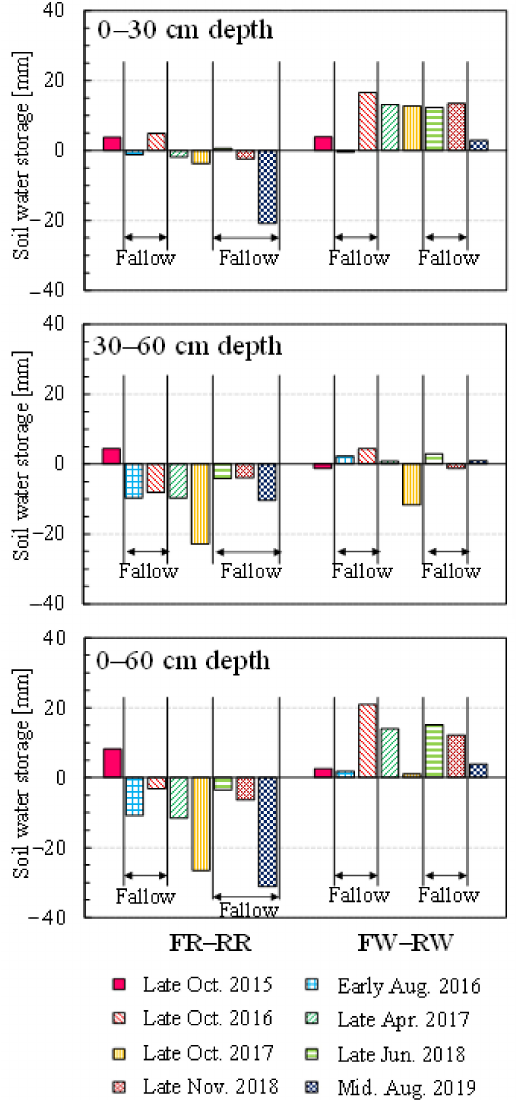
Figure 10. Differences in soil water storage between the fields and rangelands in the root zone (0–30 cm depth), below the root zone (30–60 cm depth), and in the depth of 0–60 cm in the study sites, which were calculated by subtracting the soil water storage in the adjacent rangelands from that in the fields. RW was used instead of RR for FR–RR calculations after October 2017 because RR had considerably higher infiltration than the other sites due to surface inflow from the adjacent road, which continued until 2019. FR is the rapeseed field, FW is the wheat field, RR is the